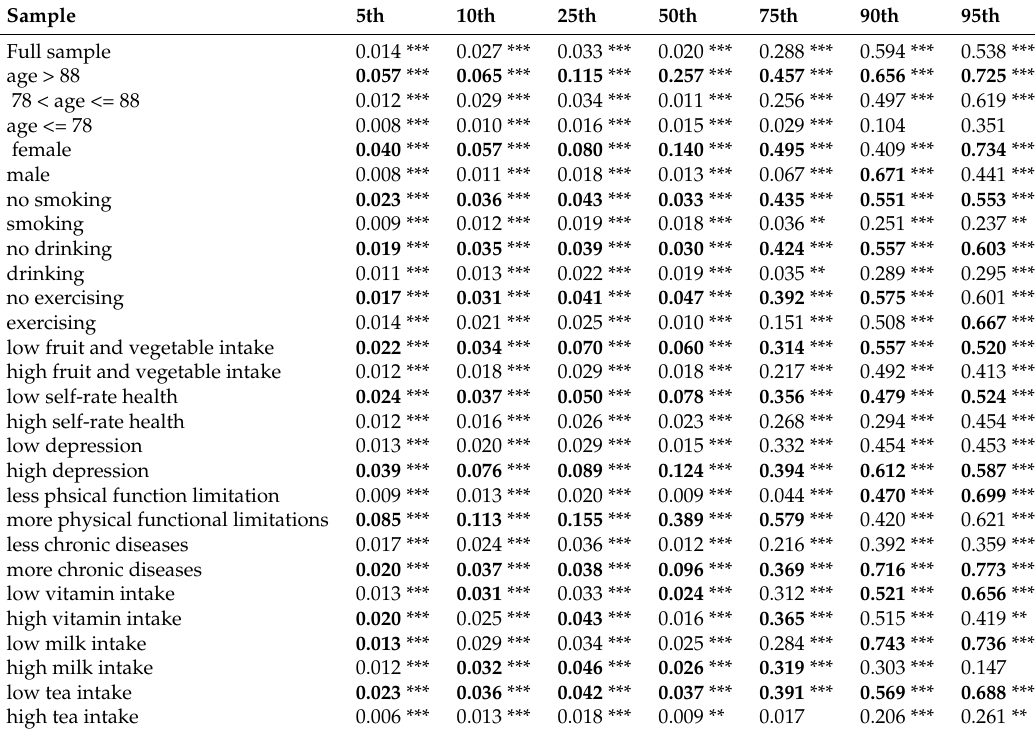
Table 4. Estimated relationship of social vulnerability on cognitive impairment across subsamples